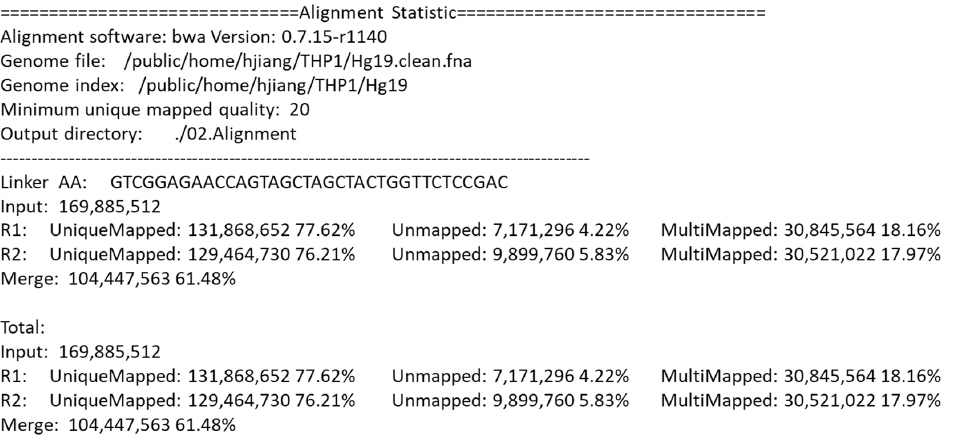
Figure 7. Statistics report of noise redundancy. 3.4. Cross Validation Cosine similarity and Pearson’s correlation coefficient (PCC) were applied to calculate the sim- ilarity between the results from the DLO Hi-C tool and the shell script. We generated a whole-genomic interaction matrix of the K562 cell line in 1-Mb resolution and calculated the simi- larity of the matrices using the DLO Hi-C tool and from the original article. The PCC and cosine similarity were both larger than 0.99 in K562-MseI-1 and K562-MseI-2, respectively, which indicates that the results of the DLO Hi-C tool have high similarity with the published results. Besides, the PCC and cosine similarity of each chromosome were larger than 0.99, which indicates the high sim- ilarity of the results (Supplementary 1: Table S1). We also compared the results of the DLO Hi-C tool with the published results through the interaction heatmap. Figure 8 shows the chroma-